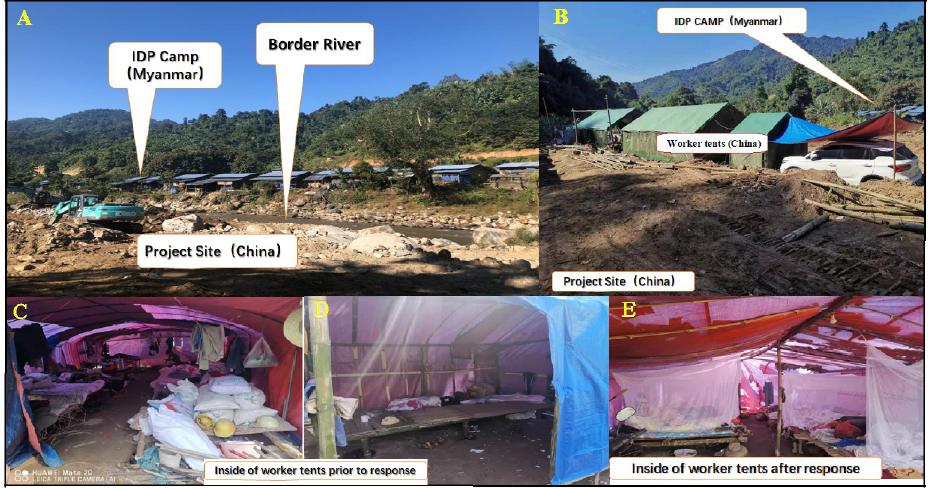
Fig 3. Pictures of worker’s residual conditions in the project sit. Internally Displaced Person (IDP); Worker Team